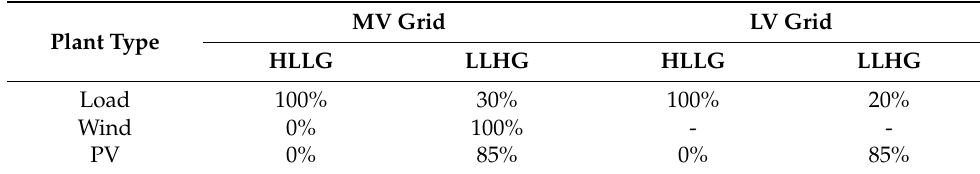
Table 1. Adopted simultaneity factors of the load and power generation in the grid planning [1]. Plant Type